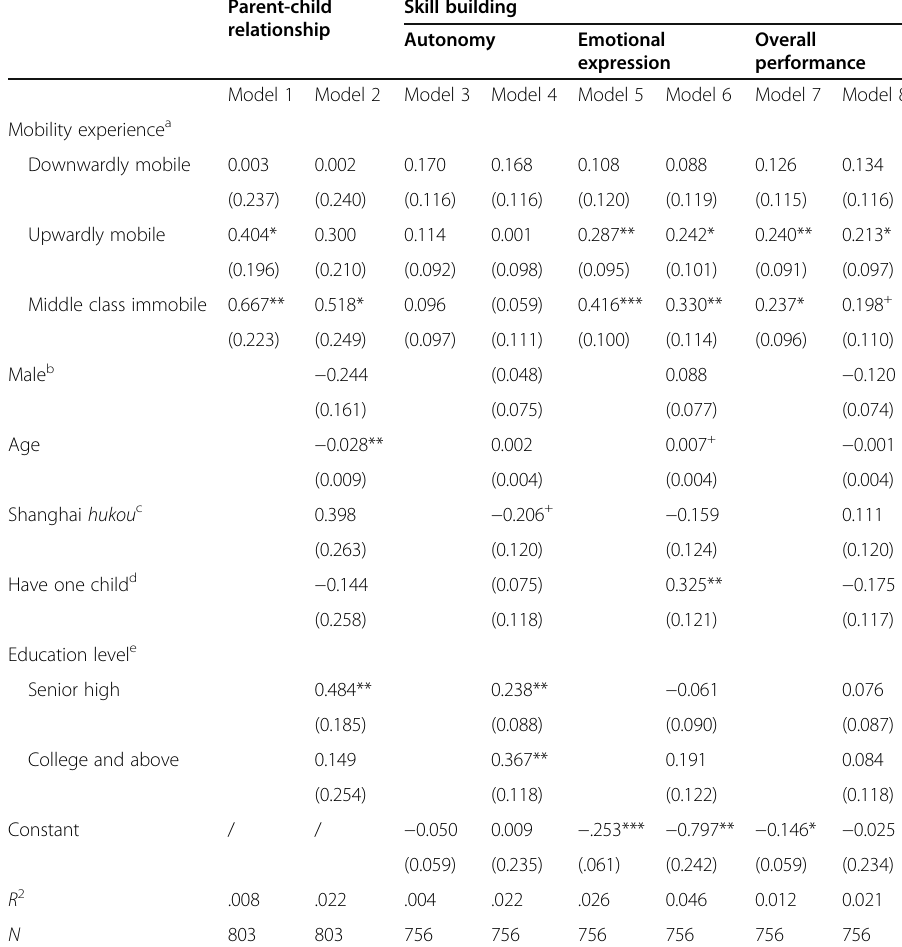
Table 5 Ordinal logistic regressions on the parent-child relationship and multivariate linear regressions on skill building in the SHFS